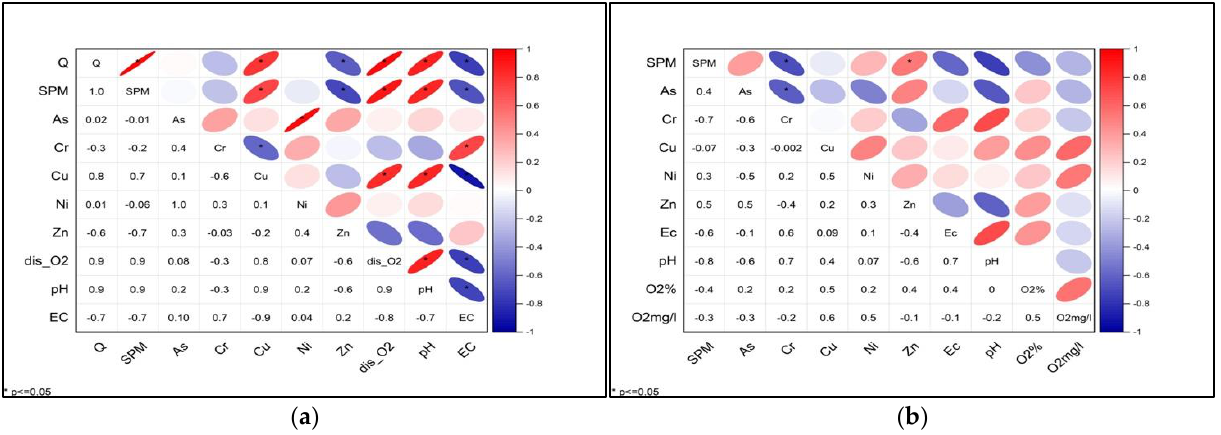
Figure 5. Spearman correlation matrix for all analysed elements with significance model set at p < 0.05: ( a ) dissolved elements from Litija and ( b ) dissolved elements from